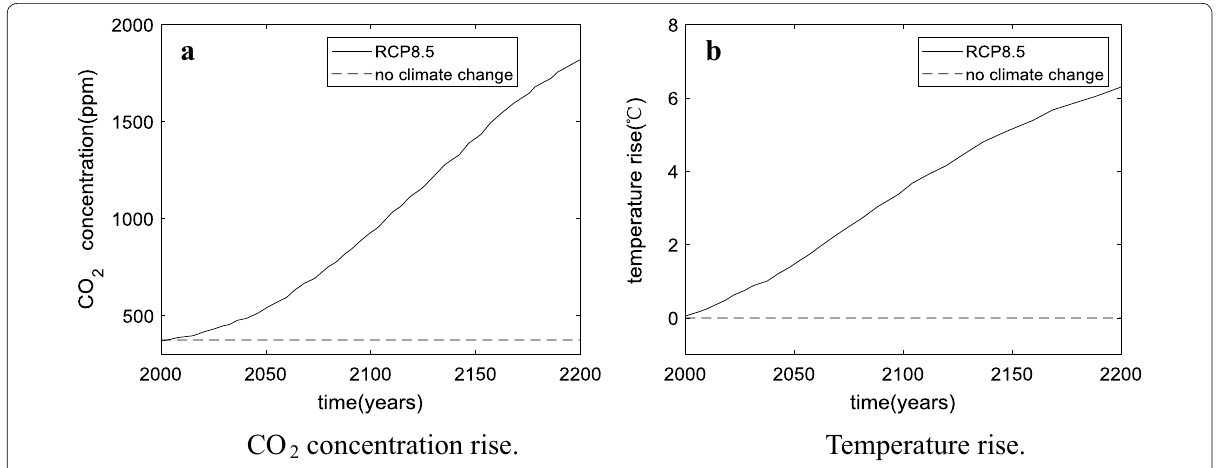
Fig. 3 Climate change scenario.